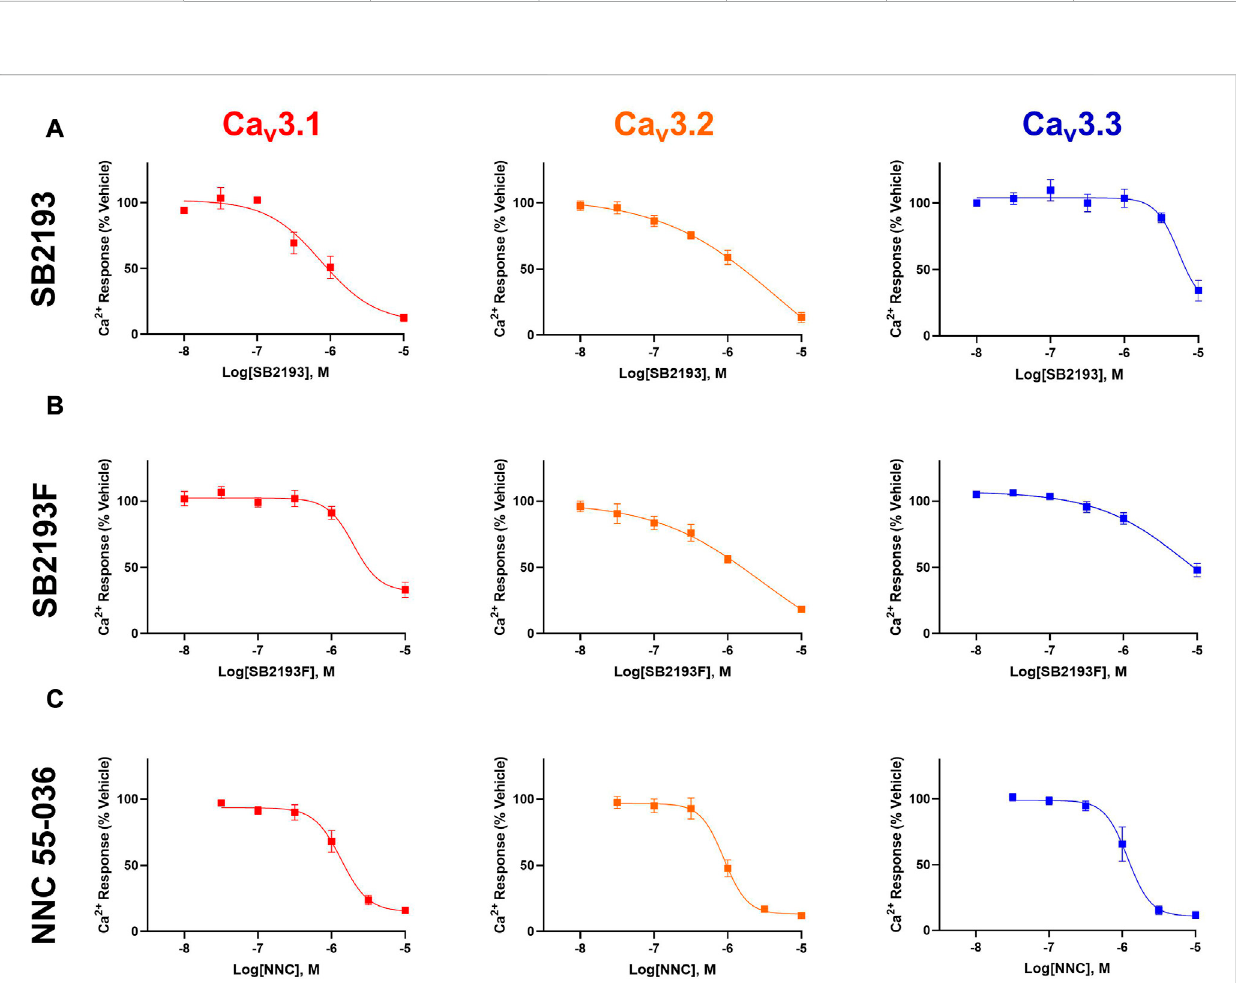
FIGURE 2 MEPIRAPIM analogues are potent inhibitors of Ca v 3 channels. Concentration-response curves of SB2193 (A) , SB2193F (B) , and NNC 55-036 (C) at Ca v 3 channel subtypes ( n = 5 – 8). Calcium response was measured in the presence of varying concentrations of each compound as measured using a fl uorometric imaging plate-reader (FLIPR) calcium fl ux assay and expressed as a percentage of response to vehicle. Data are expressed as mean ± SEM and curves represent fi t to a four-parameter log